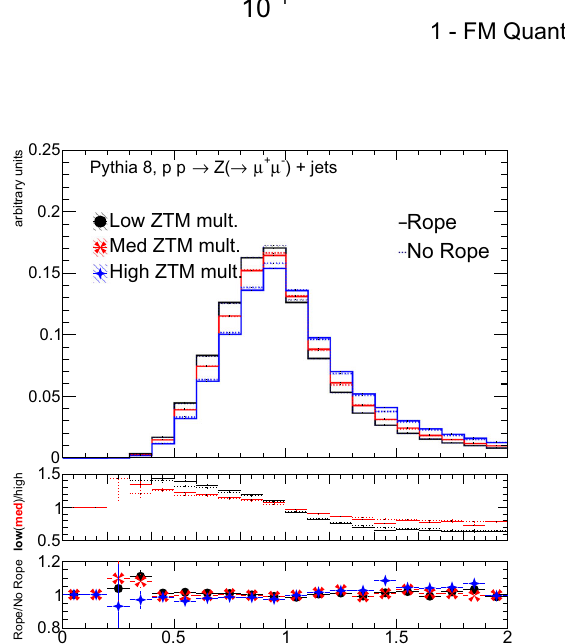
Fig. 18 The average fractional transverse momentum imbalance between leading jet and Z boson, x ZJ = p T , J / p T , Z , as a function of track multiplicity quantile, for TTM (left) and ZTM (right). Three curves in the upper panels indicate the values for the standard hadronization with and without an area correction as well as the rope hadronization with the correction. Higher multiplicities are to the left. The middle panel shows the ratio of the higher to lower Z boson p T cut (standard hadronization is shown with a dashed line, rope with solid), both including the areas correction. Finally, the lower panel shows the ratio between the rope and standard hadronization models with the p T , Z > 20 GeV requirement and both with the areas correction